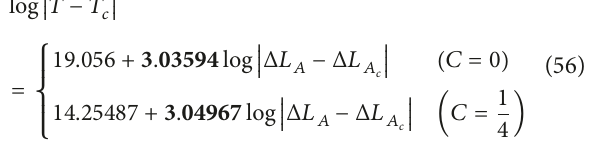
Figure 7: Plot of isocharges on the (𝑇,Δ𝐿 𝐴 ) -plan, for 𝐶 = 0 ( left ) and 𝐶 ̸= 0 ( right ). For all panels: the values of the charge are 𝑄 = 0.9𝑄 𝑐 (red), 𝑄 = 𝑄 𝑐 (dashed black), and 𝑄 = 2𝑄 𝑐